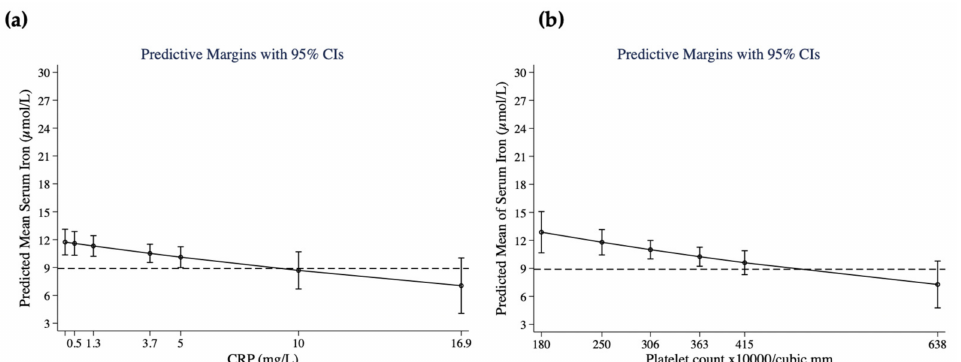
Figure 2. Predictive probabilities of ( a ) serum iron ( µ mol/L) at CRP (mg/L) quantile concentrations of 0.1 (minimum), 0.5 (25th quantile), 1.3 (median), 3.7 (75th quantile), 16.9 (maximum), and of ( b ) serum iron ( µ mol/L) at platelet count quantile numbers ( × 10 3 /mm 3 ) of 180 (minimum), 250 (25th quantile), 306 (median), 363 (75th quantile), and 638 (maximum). Additional values at CRP (5 and 10 mg/L) and platelets (415 × 10 3 /mm 3 ) are shown. Predictive margins are controlled for other variables entering the MFP regression model (Table 4C). Dashed lines denote the WHO cut-off for low serum